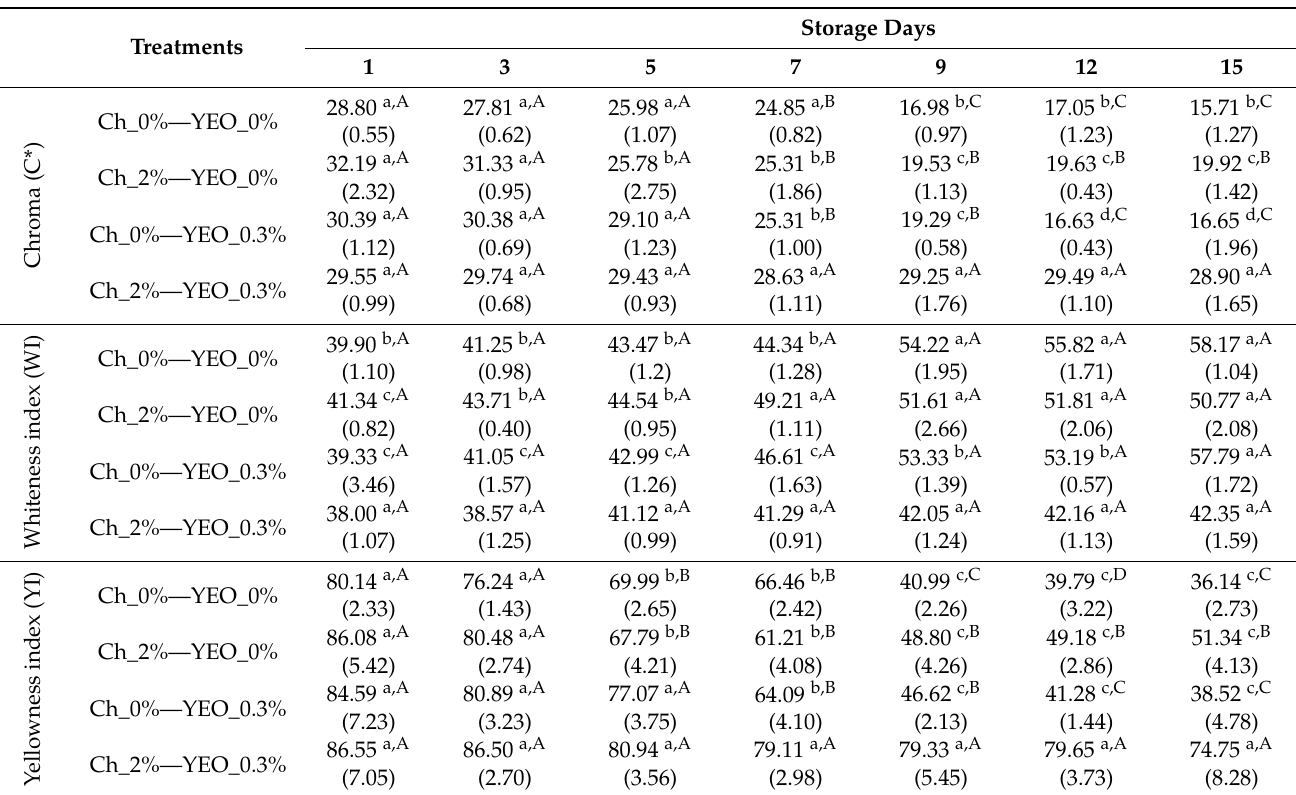
Table 5. Effect of different types of coating and storage time on color attributes (C* = chroma, WI = whiteness index, YI = yellowness index) of chicken breast fillets stored at 4 ◦